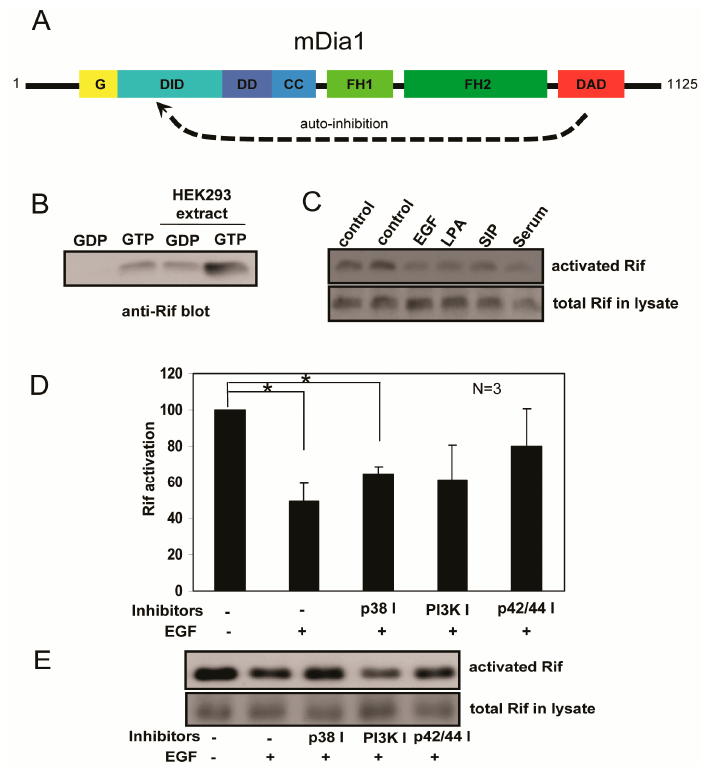
Figure 4. Rif activity was inhibited upon mitogenic stimulation mediated by MAPK or